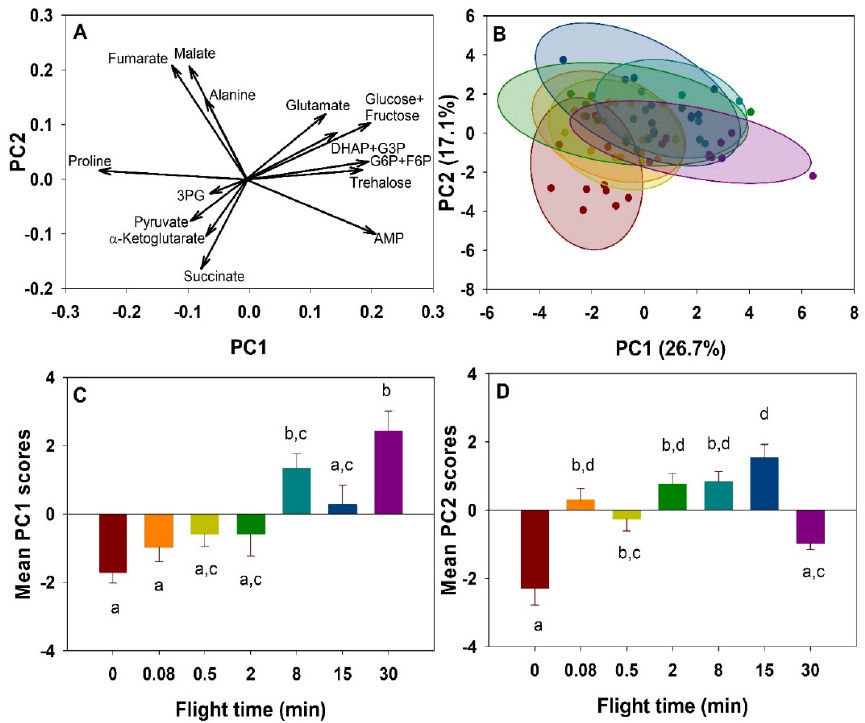
Figure 1. Changes in energy metabolism metabolite profiles during a 30-min flight in the thorax of the bumblebee Bombus impatiens . PCA plots for thoracic metabolite data. ( A) . Biplot of the thoracic metabolites. ( B ). Scores plot of collective metabolite intensities of individual bees at each time point during flight. Colors of clusters correspond to flight times (red = 0 min, orange = 5 s, yellow = 30 s, green = 2 min, light blue = 8 min, dark blue = 15 min, purple = 30 min). ( C ). Changes in mean PC1 scores over time ( p < 0.001). ( D ). Changes in mean PC2 scores over time ( p < 0.001). Columns that do not share a letter are significantly